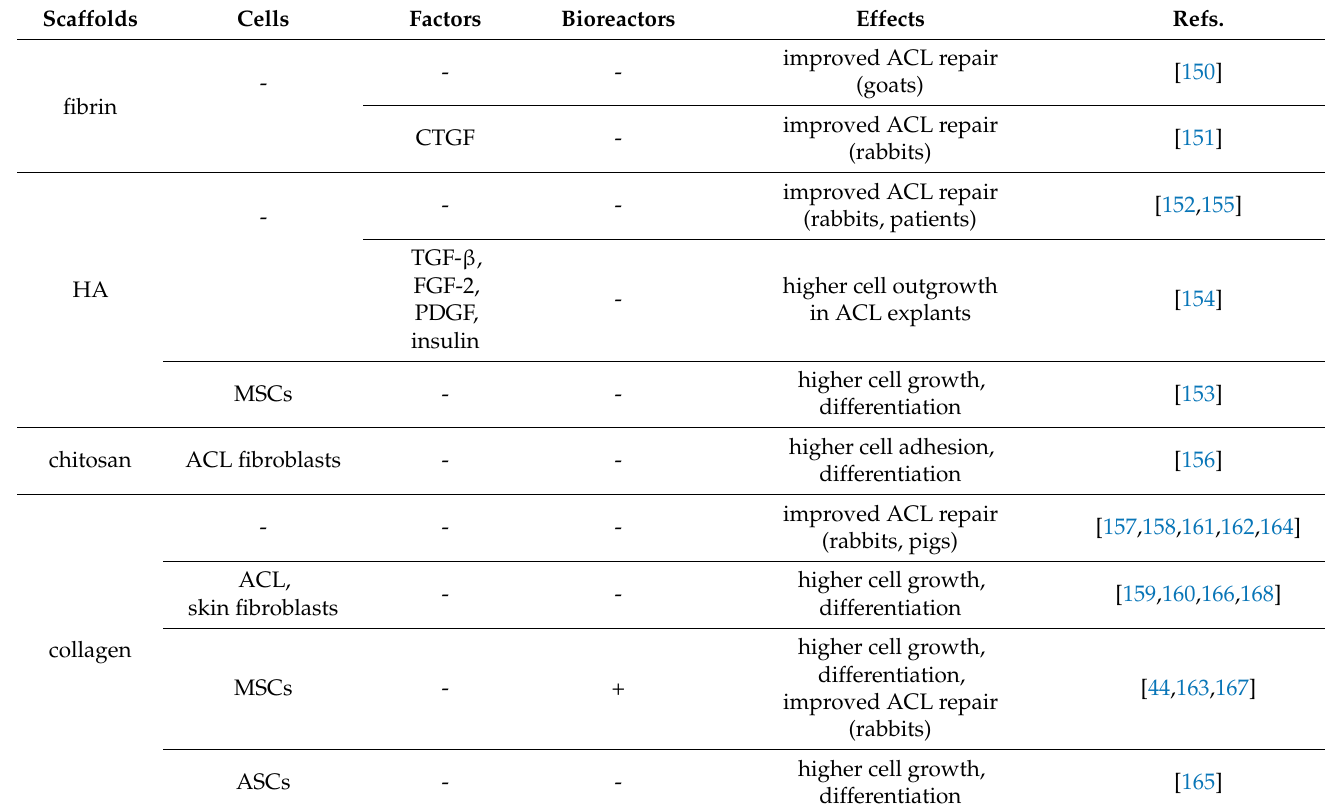
Table 1. Applications of tissue engineering for ACL